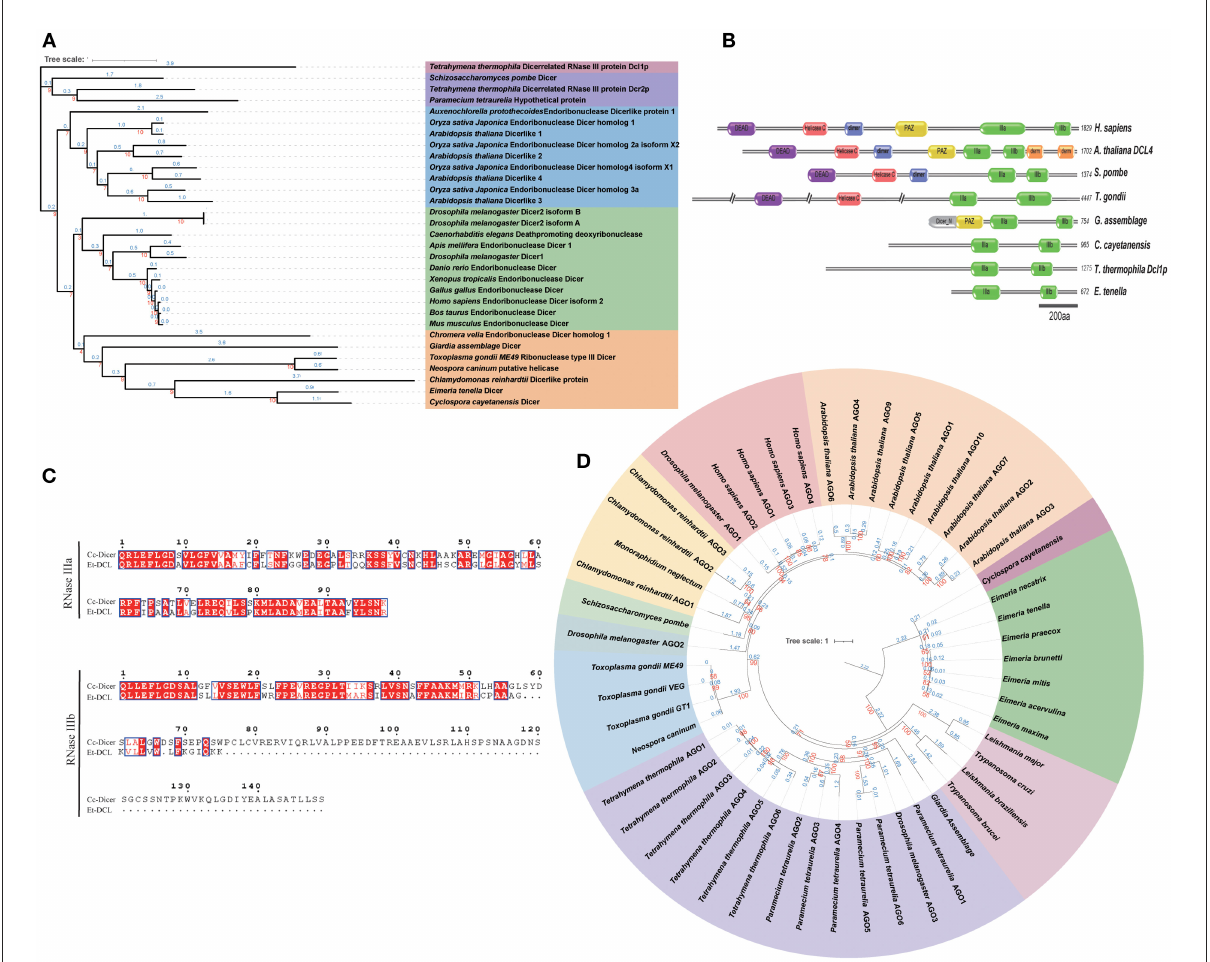
FIGURE1 Domain organization and phylogenetic analysis of Dicer and Ago proteins. (A) Dicer-based maximum likelihood tree showing the evolutionary relationships between Eimeria and other species. Protein sequences were aligned by Muscle software, and the unrooted maximum likelihood tree was constructed using IQ-TREE2 with 1,000 bootstrap replicates. (B) Domain organization of Dicer proteins. IIIa, RNase IIIa; IIIb, RNase IIIb; PAZ, Piwi-Argonaute-Zwille domain; dsrm, recognizable dsRNA binding domain; Helicase C, RNA helicase domain; DEAD, DEAD box helicase; dimer, Dicer dimerisation domain. (C) Sequence alignment of conserved RNase domains of Dicer proteins from E. tenella and C. cayetanensis . (D) Argonaute-based maximum likelihood tree (rooted at midpoint) showing the evolutionary relationships between Eimeria and other species. Red and blue numbers on both phylogenetic trees represent the bootstrap values (%) and branch lengths, respectively. Protein accession ID shown in Supplementary Datasets 10,